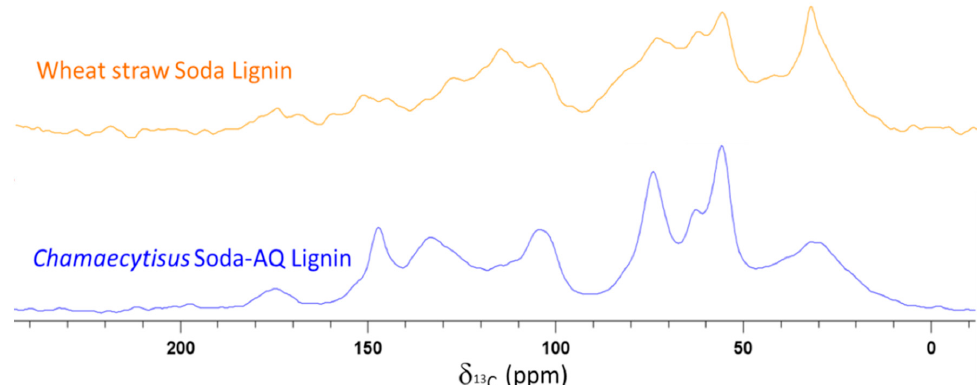
Figure 5. 13 C-CPMAS solid-state NMR spectra of lignin samples from wheat and Chamaecytisus lignin extracts. Spectra for lignin isolated from Leucaena and barley are shown in Figure S1